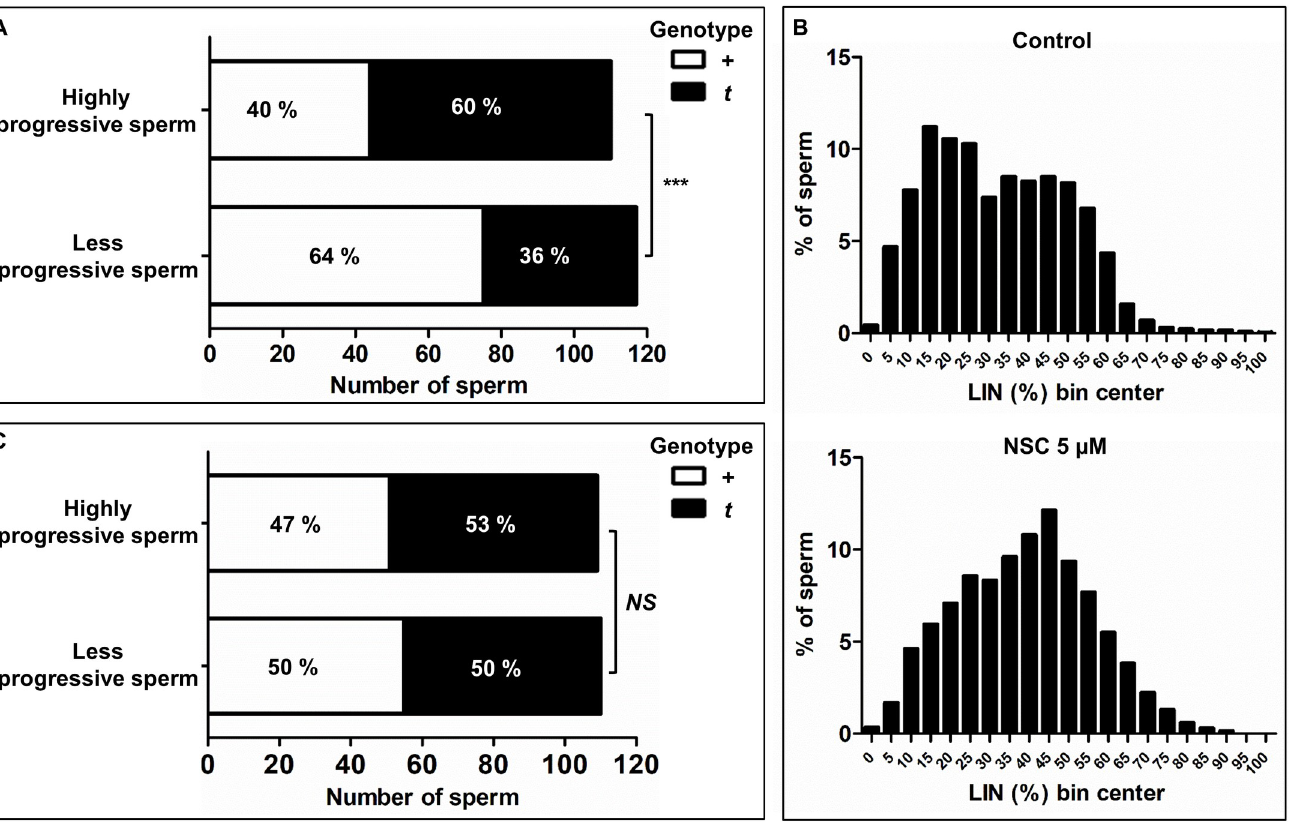
Fig 5. Effect of RAC1 inhibition on progressive motility of (+) sperm from heterozygous ( t /+) mice. (A, C) Bar graphs showing the percentage of highly vs . less progressive sperm singly genotyped as + or t carriers. (A) Sperm isolated from t/+ samples. (C) Sperm isolated from t/+ samples incubated with 5 μ M NSC23766 for 30 min. Asterisks indicate association ( ��� P < 0.001) and NS (not significant) a random relation between progressiveness and t genotype of sperm. (B) Histograms showing the frequency distribution of sperm over linearity (LIN; %) bins in t /+ samples (n = 7) incubated without (controls; upper graph; n = 2019 sperm) or with 5 μ M NSC23766 (lower graph; n = 2306 sperm) for 30